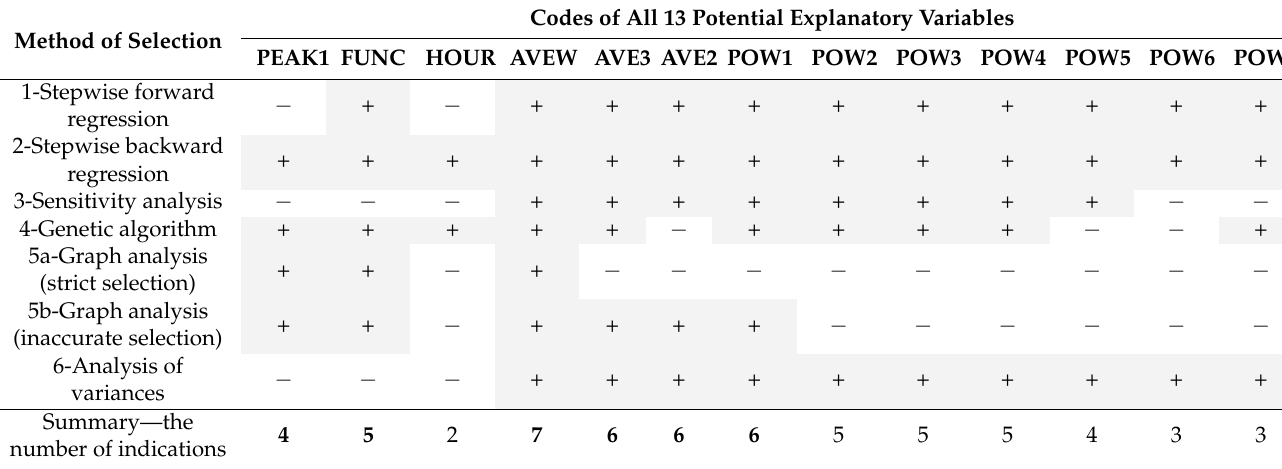
Table 4. Results of the initial selection of explanatory variables for all 6 methods of selection—selection for time series No. 2. Method of